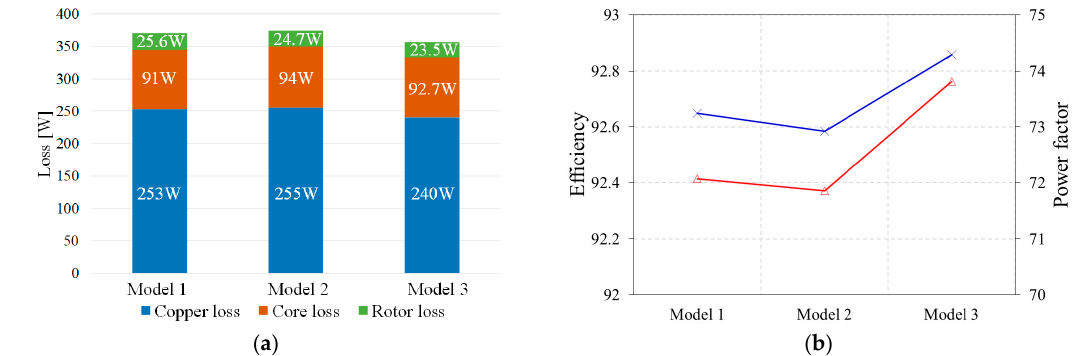
Figure 9. Electromagnetic analysis result using FEA according to the position of magnet: ( a ) loss, ( b ) efficiency and power factor.